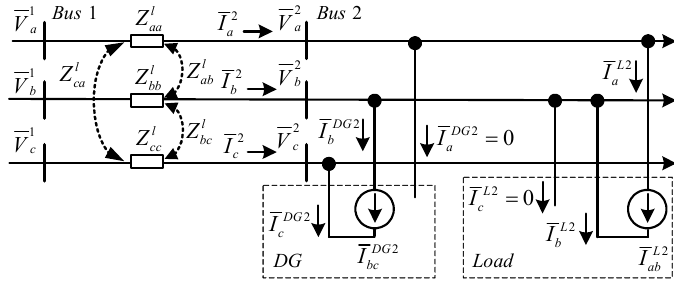
Figure 2. Equivalent circuit model between two buses.